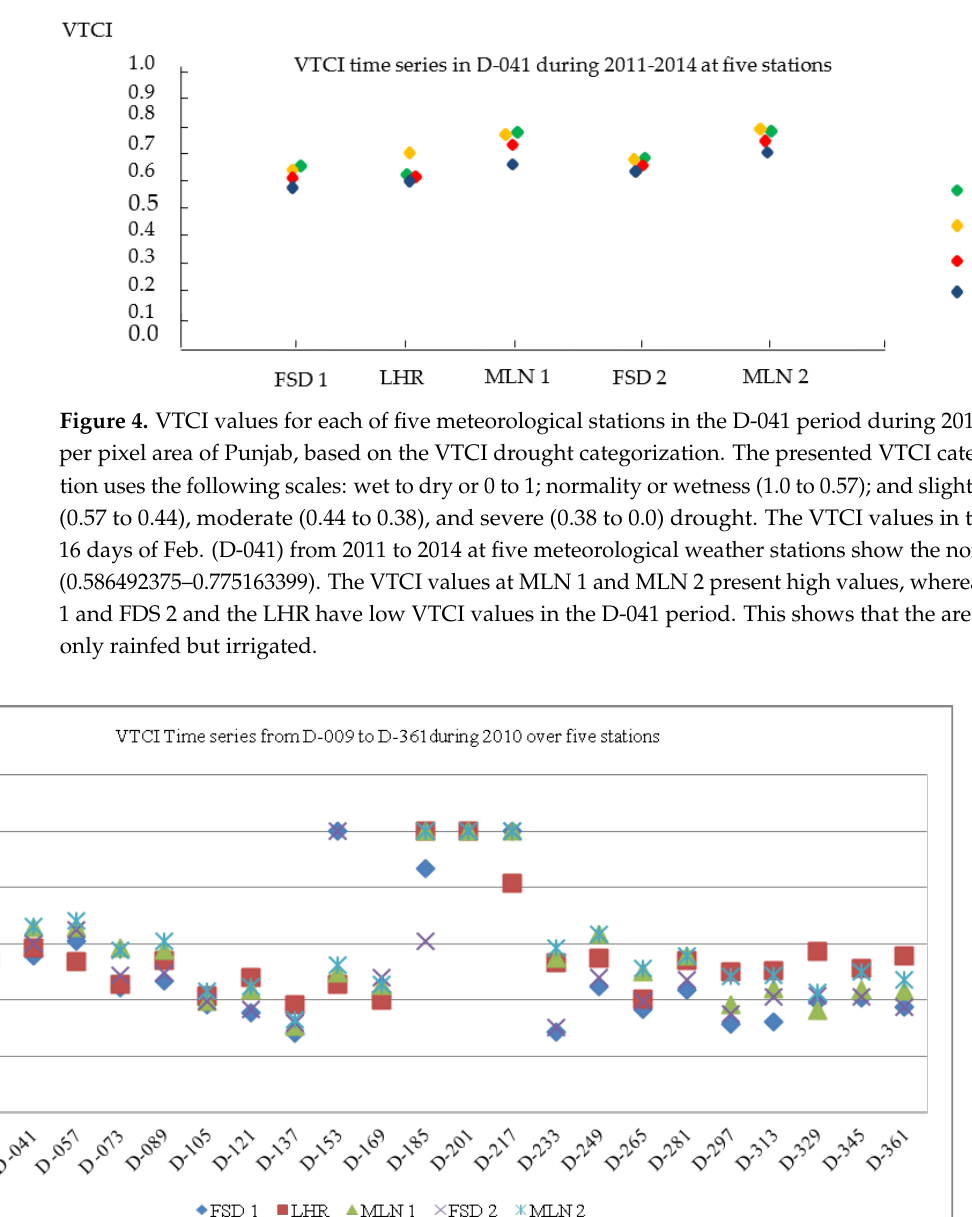
Figure 5. The VTCI values over five meteorological stations for days of the year (D-009 to D-361) during 2010 per pixel area on a scale of 0.0 – 1.0. The presented values show the drought, flood duration, and intensity (e.g., the values at D-185 indicate heavy rainfall, and values at D-201 – 232 indicate the flood duration, and intensity) at five stations over the Punjab region.